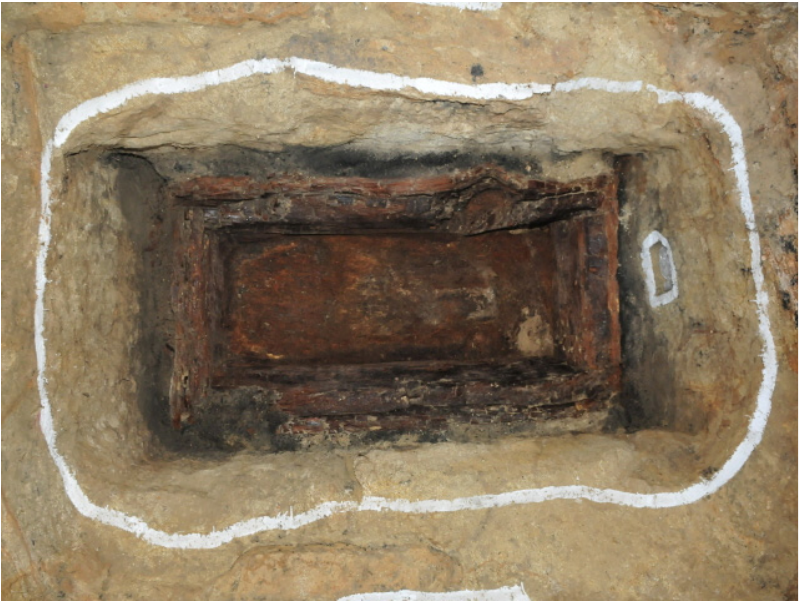
Figure 12. The wooden coffin construct at the Nongso Tomb at the time of discovery. After (Kungnip Naju munhwajae y ŏ n’guso 2014, p. 5, Figure 5).